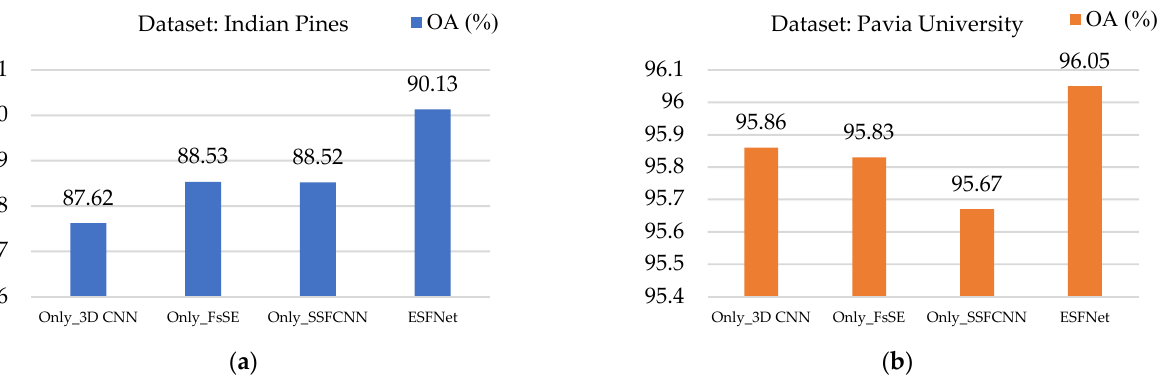
Figure 8. Comparison results of the four models on two datasets. ( a ) Accuracies of the four models on the Indian Pines dataset; ( b ) Accuracies of the four models on the Pavia University dataset.